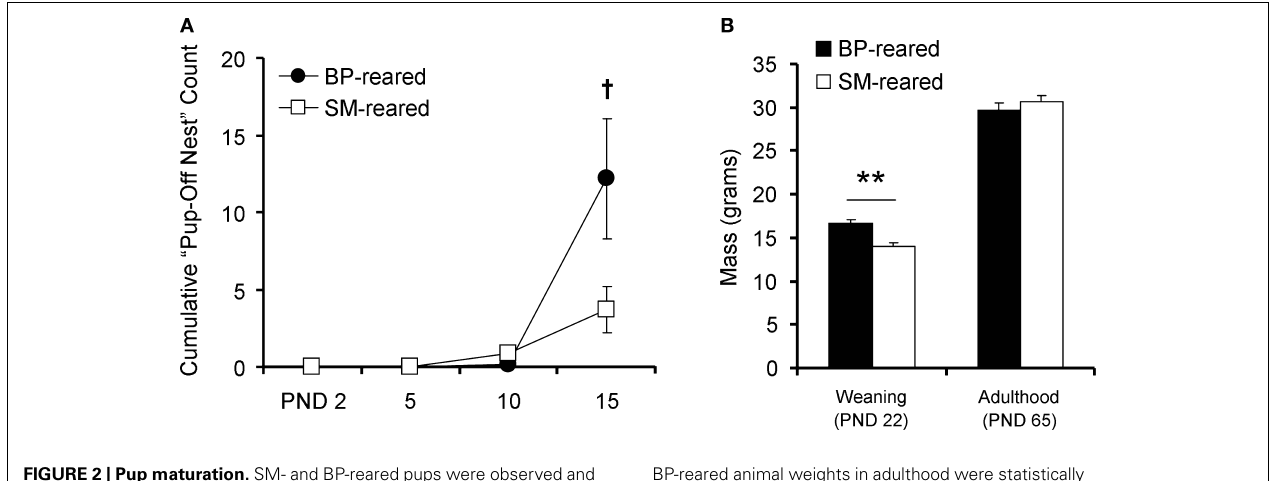
FIGURE 2 | Pup maturation. SM- and BP-reared pups were observed and weighed to obtain maturational measurements. SM-reared pups ventured off the nest less frequently ( (A) , although this reached only trend level) and weighed less at weaning (B) than BP-reared offspring. SM- and